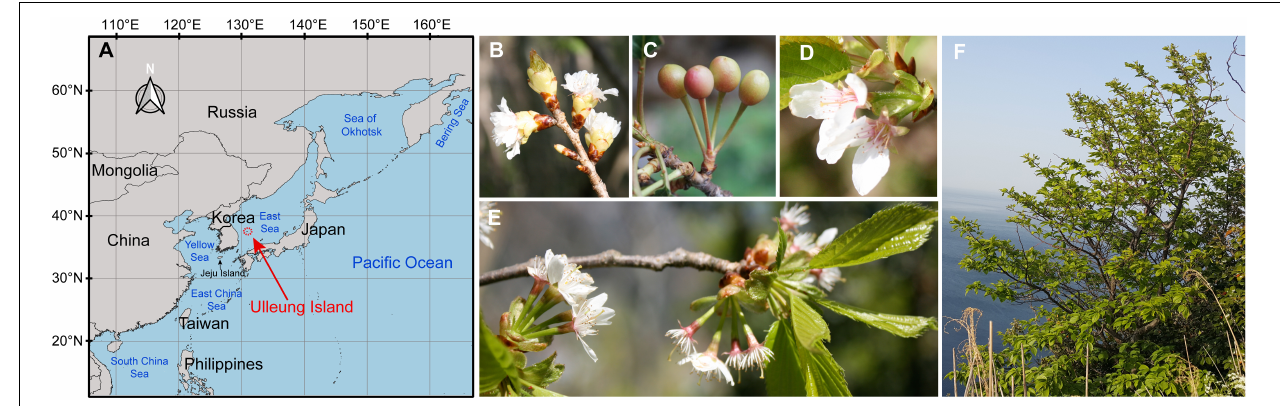
FIGURE 1 | A map showing the location of Ulleung Island (A) , and photographs of the wild flowering cherry, Prunus takesimensis , endemic to Ulleung Island, South Korea (B–F)